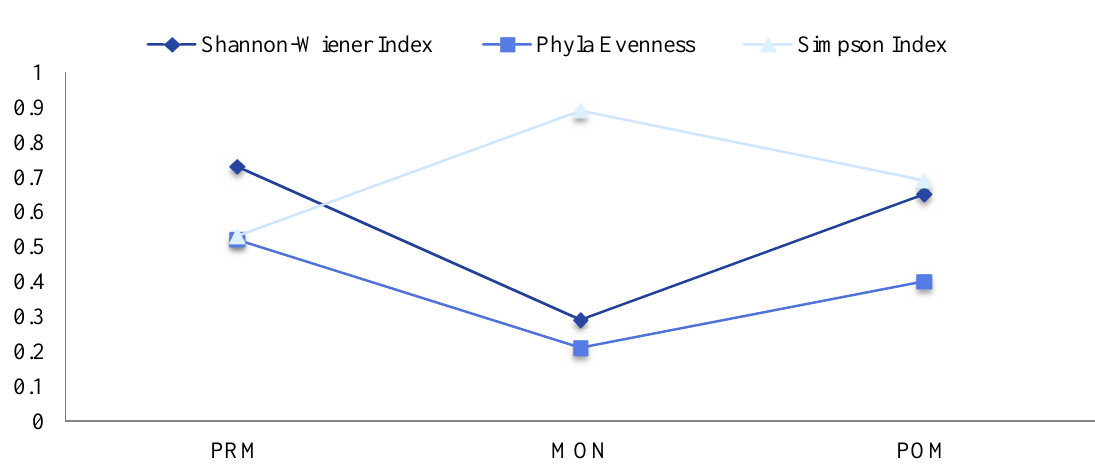
Figure 4. Seasonal variations in phyla diversity indices of macroinvertebrates PRM: Premonsoon; MON: Monsoon; POM: Postmonsoon